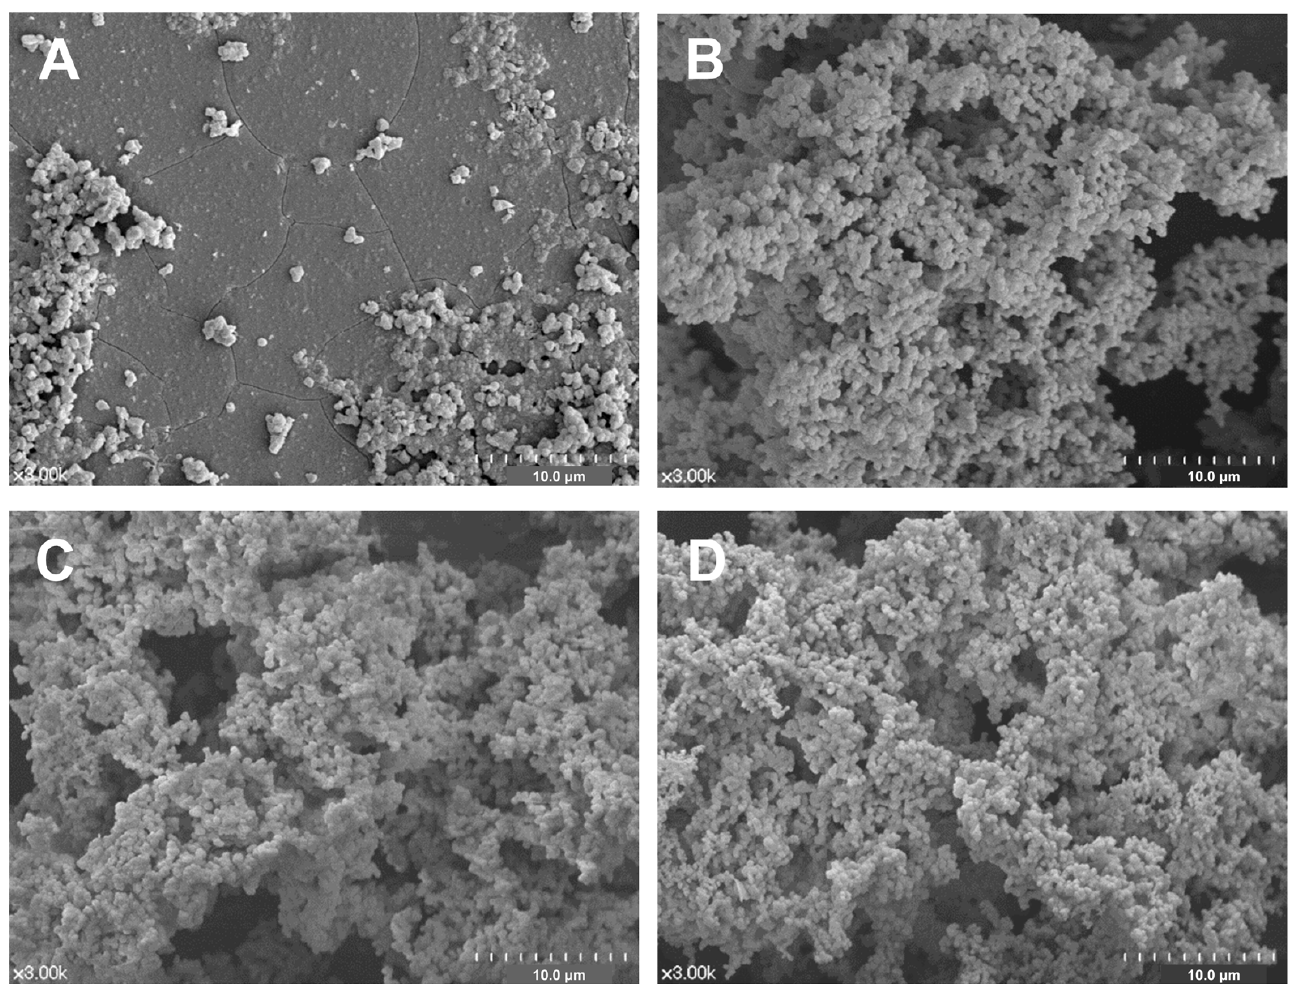
Figure 4. Representative surface morphology of the all experimental desensitizing agents after 2-week storage in SBF: ( A ) SNP, ( B ) BAG, ( C ) BAGMDP, and ( D ) BAGMETA groups.